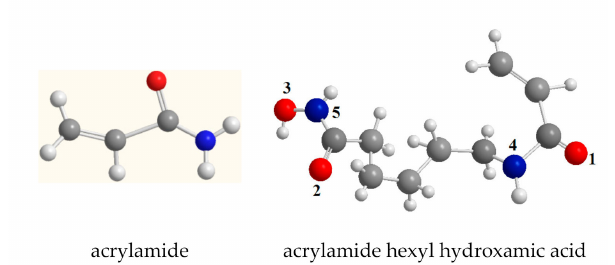
Figure 1. Optimization of molecular